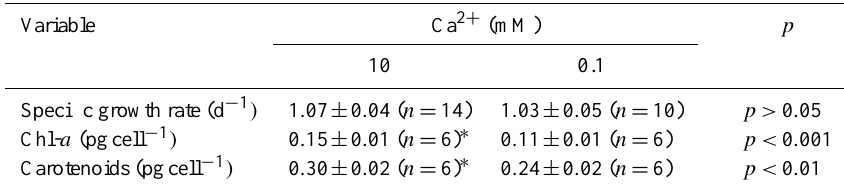
Table 2. Growth rate (in d − 1 ) , chl- a and carotenoid content (in pgcell − 1 ) of Emiliania huxleyi cells acclimated to 10mM (HCa) or 0.1mMCa 2 + (LCa) for at least 148 generations. N represents the number of samples. The asterisks represent significant differences between two Ca 2 +